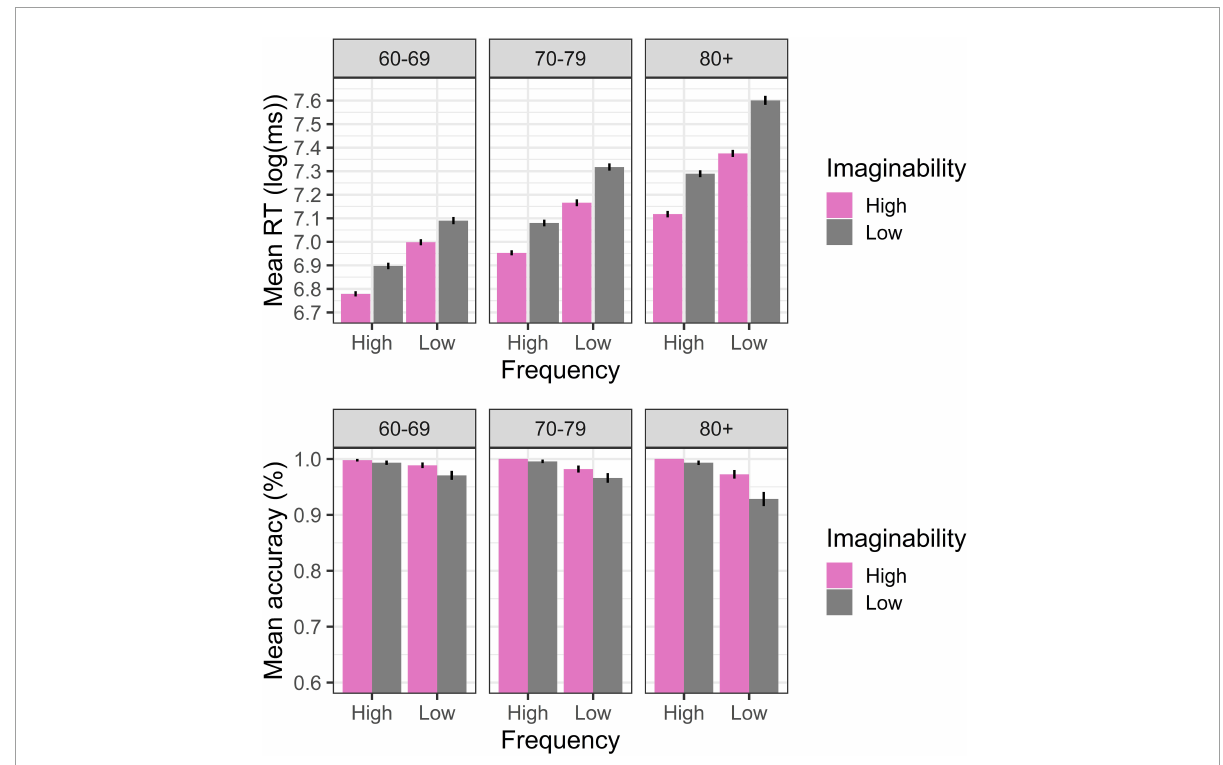
FIGURE3 Word response pattern on RT (log) and accuracy in Experiment